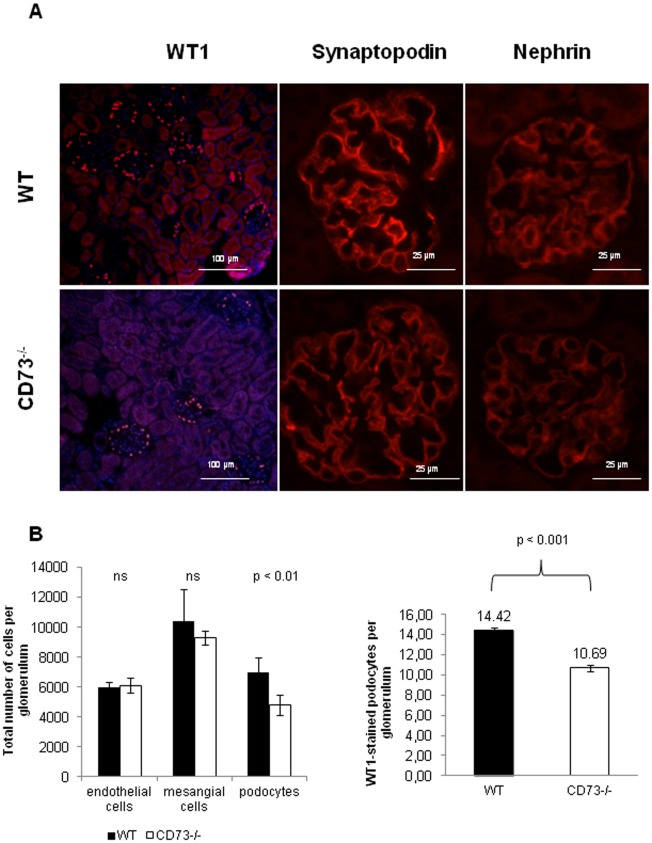
Reduced number of podcytes in CD73−/−mice.(A) The expression of the podocyte markers WT1, synaptopodin and nephrin was immunohistochemically detected on 6 µM cryosections of the renal cortex of CD73−/−mice vs. WT-mice. Images are representative of 6–7 animals per group. (B) Statistical analysis showed a decreased number of WT1-stained podocytes per glomerulus (counted in 30 glomeruli per section and 7 mice per group), means ± SEM, p<0.0001 according to Student t-test (left panel). Histomorphometrical analysis (integration plate II, Zeiss Co., magnitude of 100×, oil immersion) confirmed reduced podocytes per glomerulus as compared to other glomerular cells (n = 5−6 mice per group), means ± SD, p<0.01 according to Student t-test (right panel).